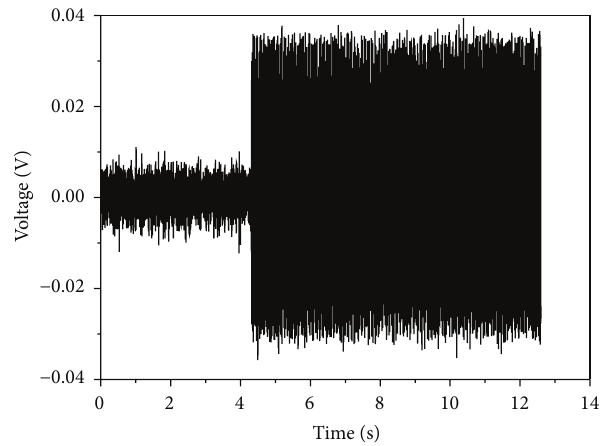
Figure9:Changeofself-inducedvoltagefromposition2toposition 3.